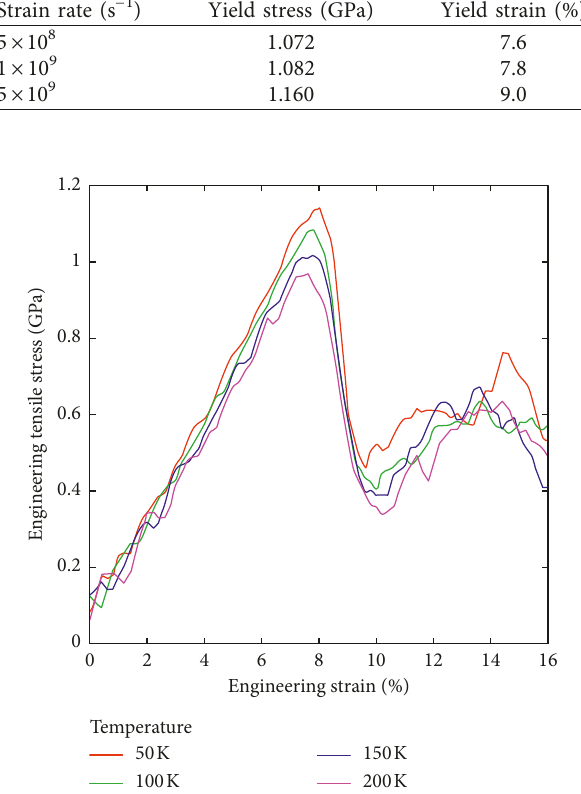
Figure 3: The dependence of yield stress and strain on temperature. The simulation parameters are same as in Table 1. Table 3: The yield stress and strain as a function of temperature. Temperature (K)